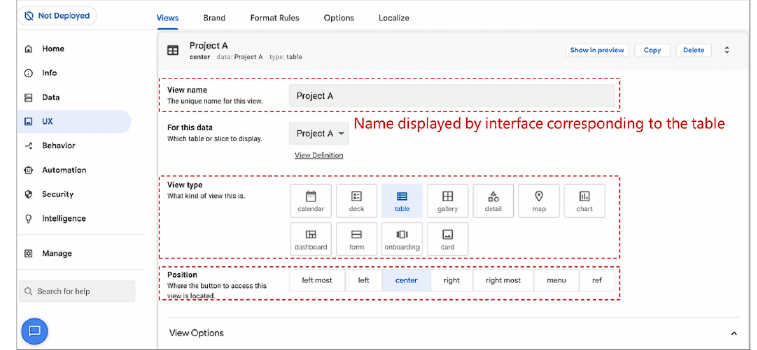
Figure 17. Screen image for design of interface corresponding to table